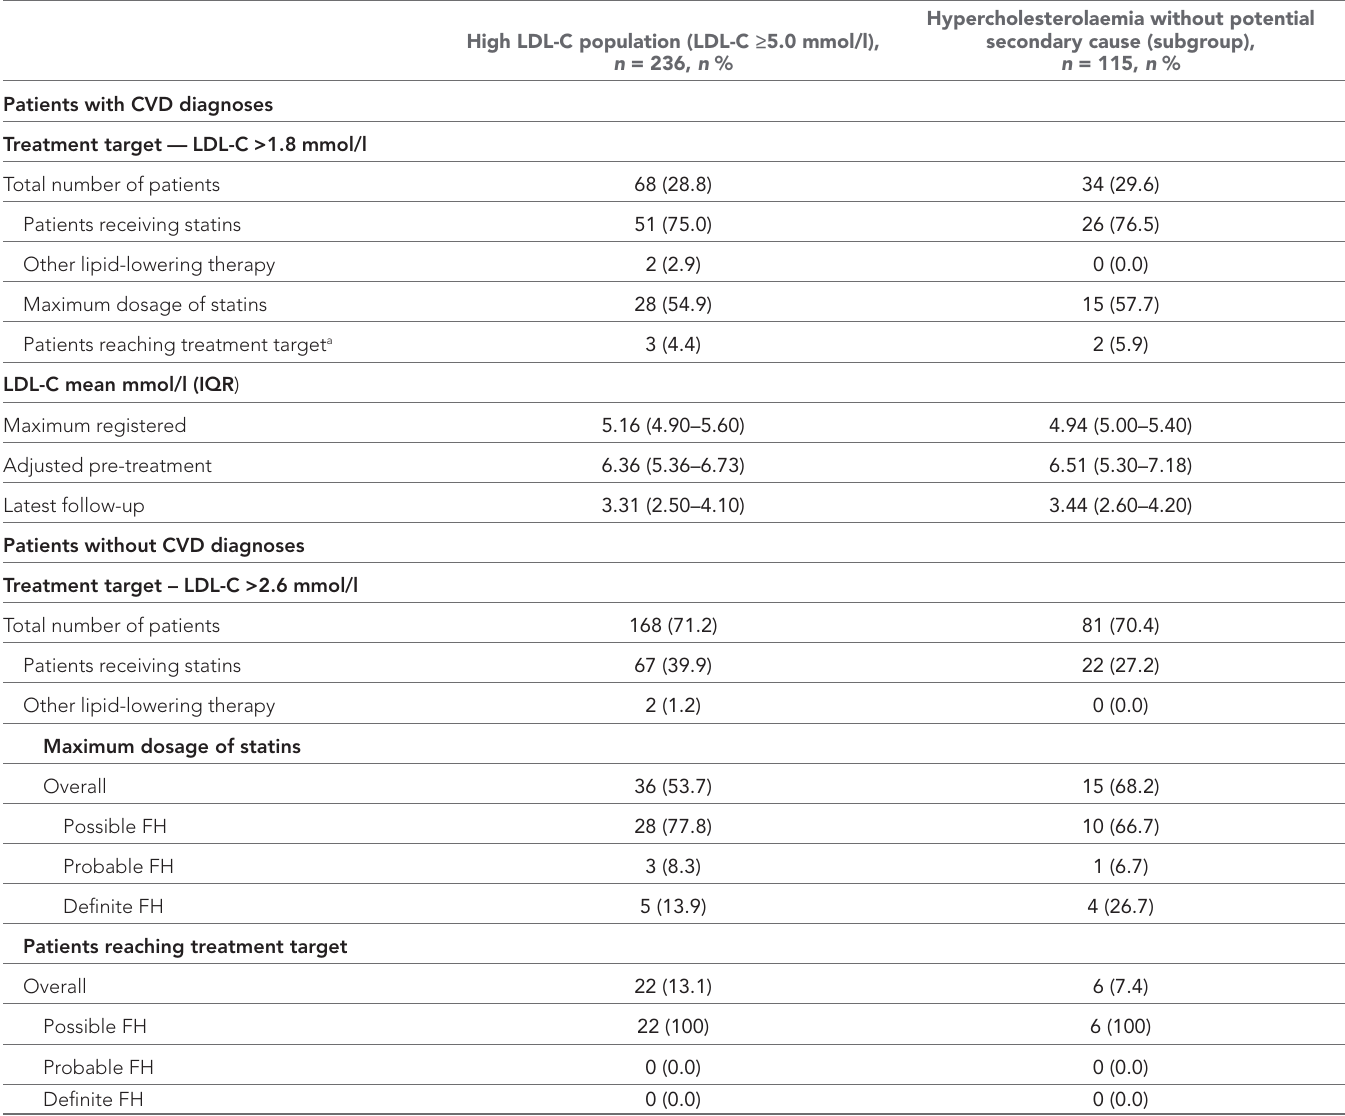
Table 4 Evaluation of lipid- lowering